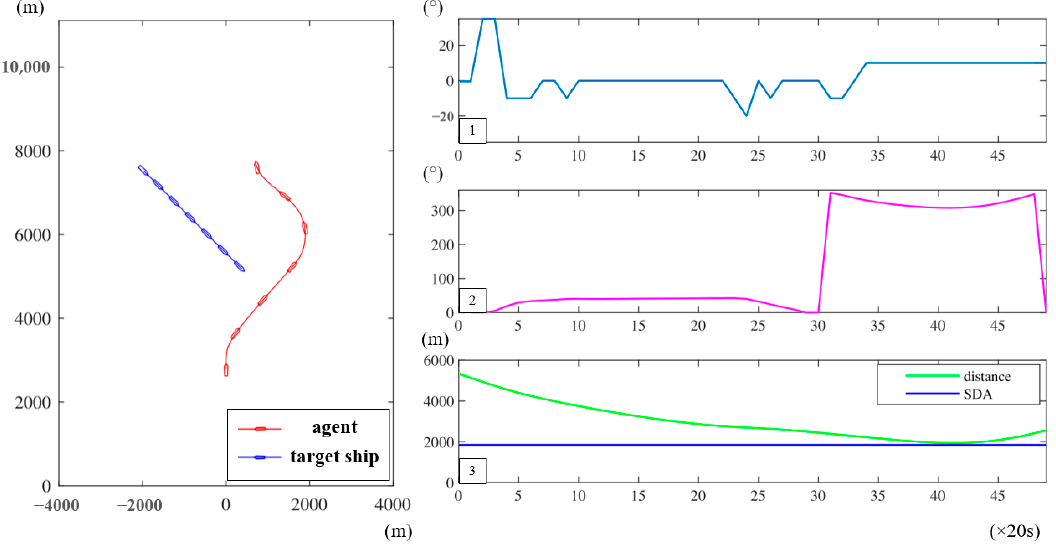
Figure 14. Simulation result for two-ship-collision avoidance in the scenario where the stand-on ship needs to take actions (1: rudder angle; 2: course; 3: distance).